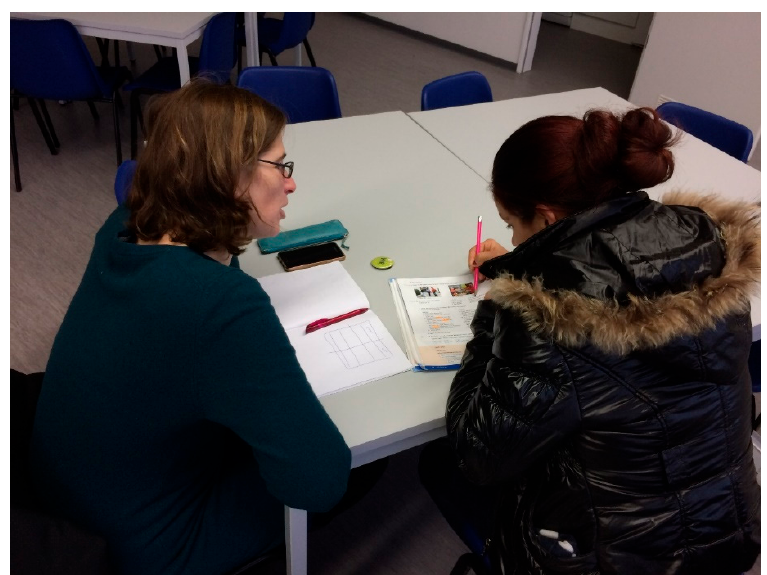
Figure 1. The author volunteering with homework tutoring (photo credit: Udo Schoeler).